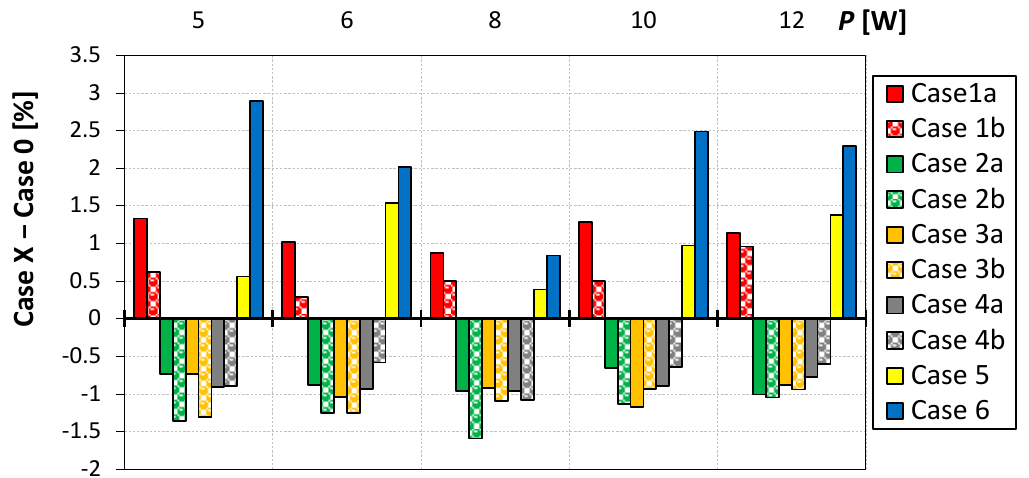
Figure 8. Differences between SPL generated by actuator with chevron orifice and circular orifice.